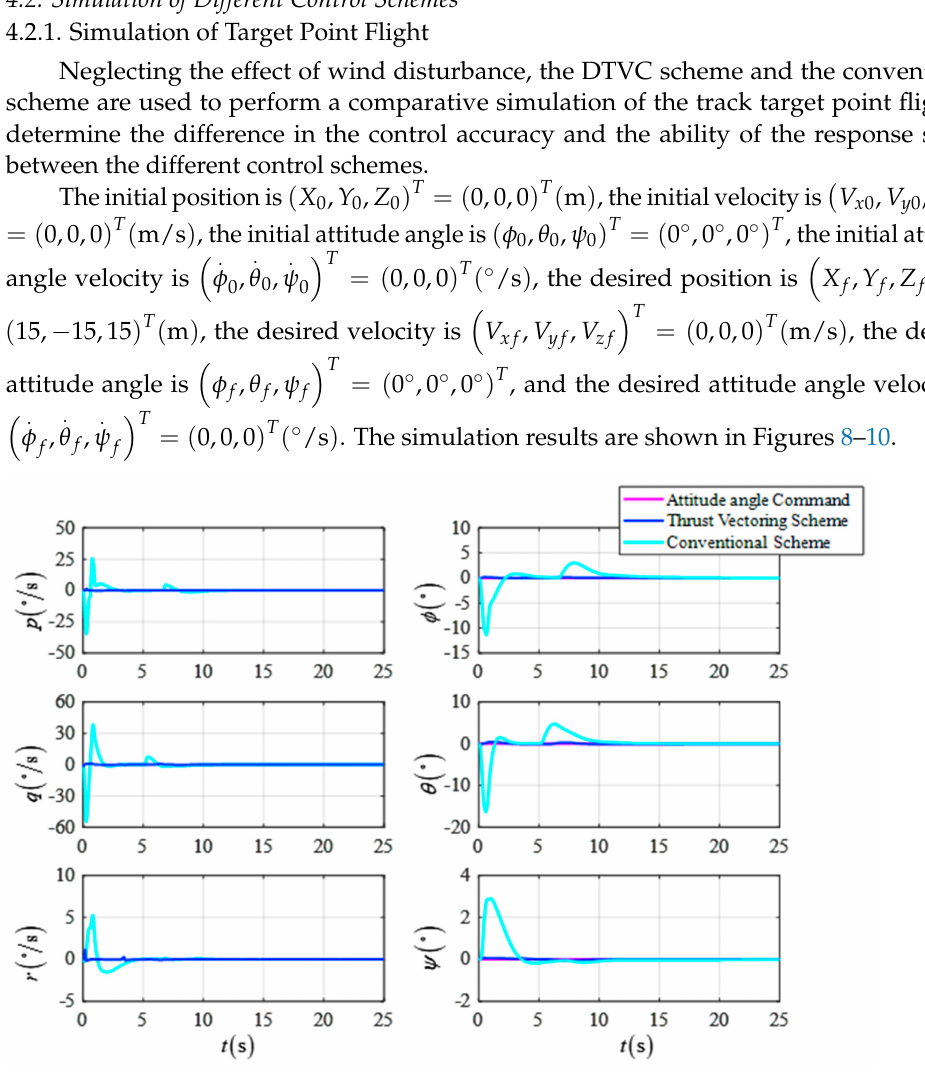
Figure 8. The attitude angle and the attitude angular velocity in the target point